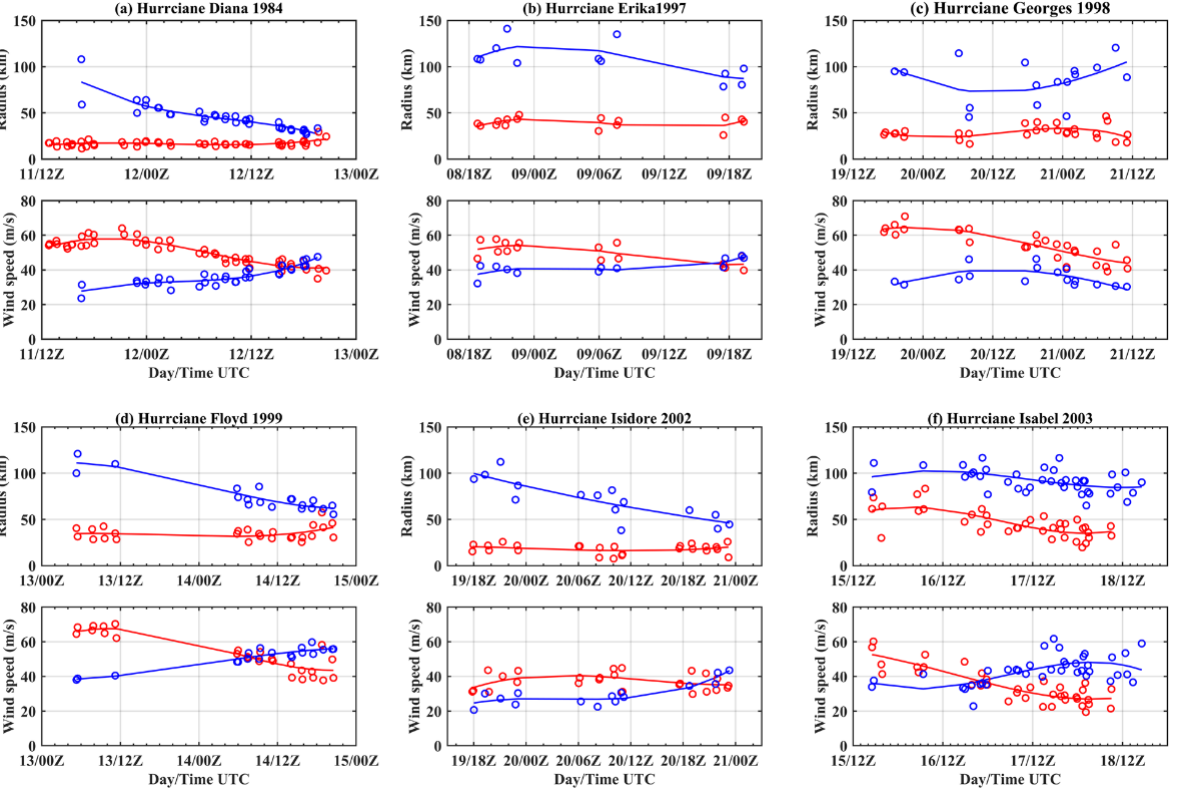
Figure 4. Model validations from ( a ) Hurricane Diana (1984), ( b ) Hurricane Erika (1997), ( c ) Hurricane Georges (1998), ( d ) Hurricane Floyd (1999), ( e ) Hurricane Isidore (2002), and ( f ) Hurricane Isabel (2003). The top panel in each subfigure denotes the evolution of radii parameters r 1 (red circles) and r 2 (blue circles). The bottom panel in each subfigure denotes the evolution of intensity parameters v 1 (red circles) and v 2 (blue circles). Each time series of wind profile parameters are determined using a third-order polynomial best fit approach (solid lines).